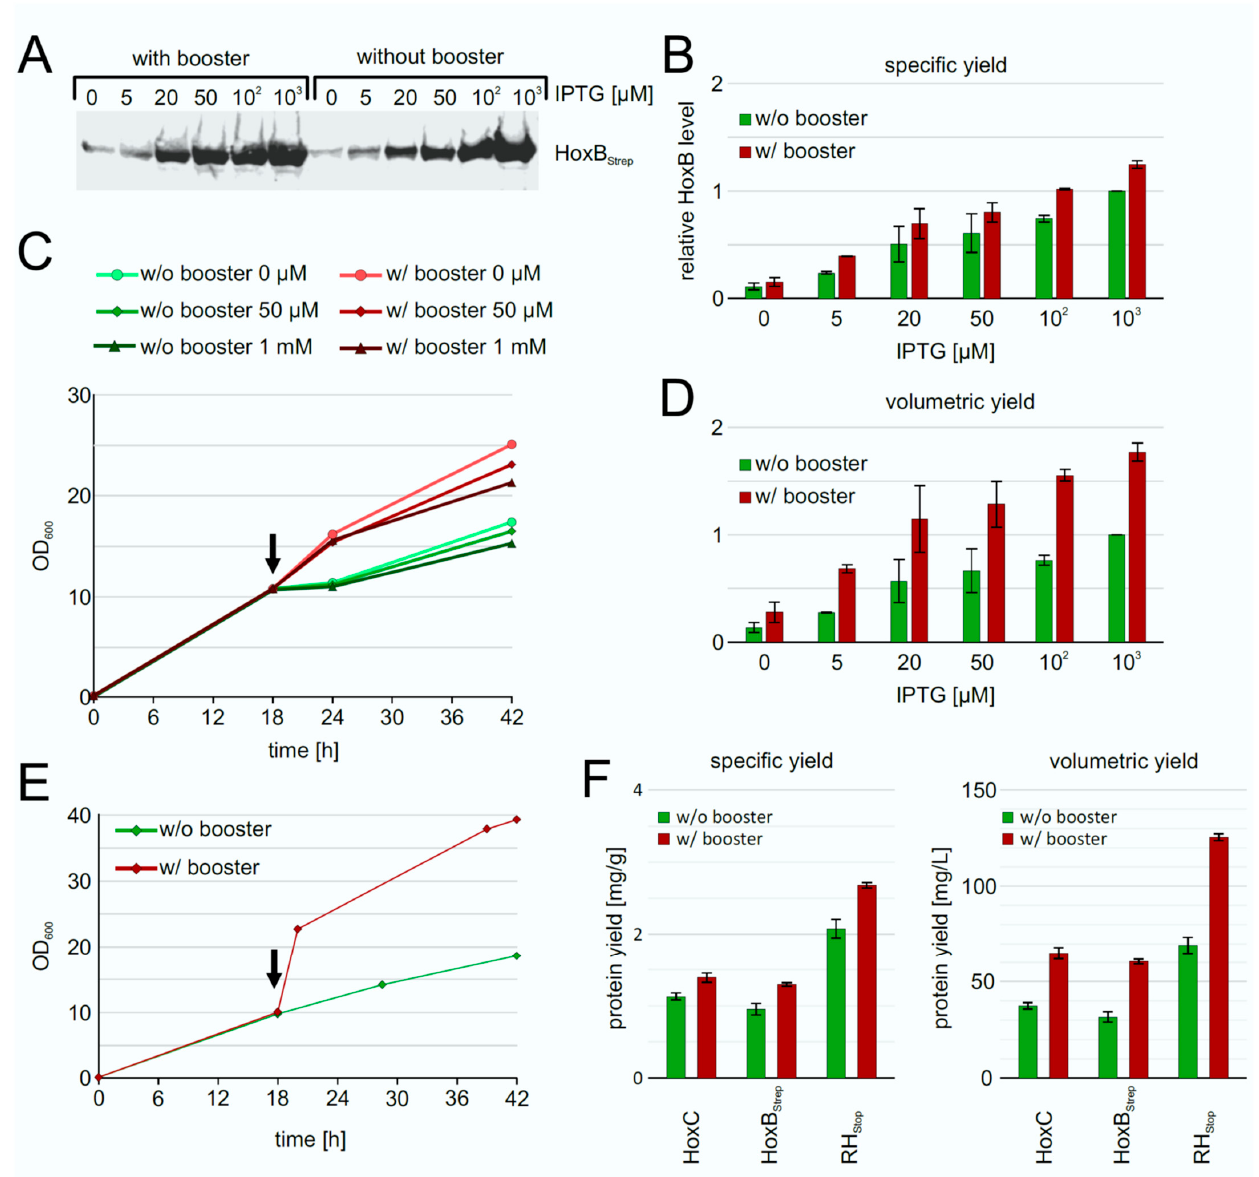
Figure 5. Heterologous production of RH by strain BQF8RH grown in EnPresso B medium with or without addition of booster. Cells were cultivated in deepwell plates at 30 ° C as described in Materials and Methods. RH production was induced with varying IPTG concentrations. ( A ) Analysis of HoxB production by Western blotting with anti-Strep-tag antibodies. ( B ) Calculation of the specific HoxB yield normalized to the yield in non-boosted cultures induced with 1 mM IPTG. ( C ) Growth curve of representative cultures. The black arrow indicates the induction point. ( D ) Calculation of the volumetric HoxB yield normalized as in B . ( E ) Growth curves of strain BQF8RH in 50 mL EnPresso medium with or without booster in UYF. ( F ) Calculation of specific and volumetric RH yield from strain BQF8RH as grown in E